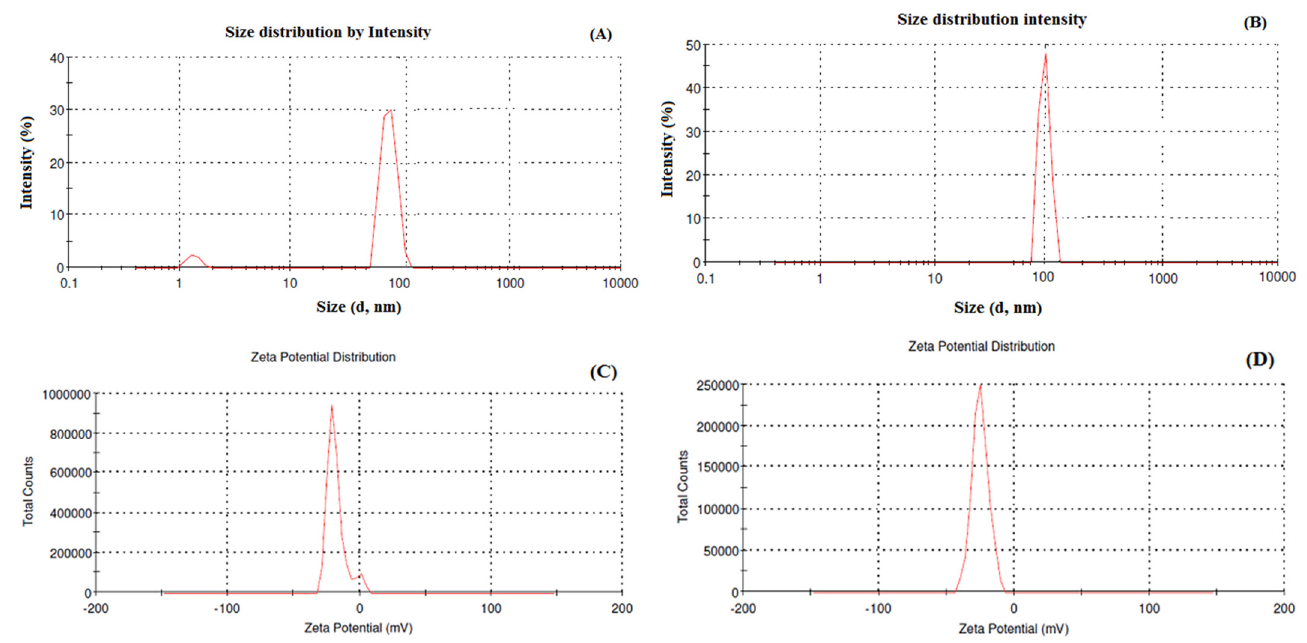
Figure 3. Particle size and size distribution analysis of Dox–Erlo NPs ( A ), particle size and size distribution analysis of Dox–Erlo-NP conjugates ( B ), zeta potential of Dox–Erlo NPs ( C ) and Dox–Erlo-NP conjugates ( D ). Table 5. The optimized composition using experimental design for the development of Dox–Erlo NPs with experimental and predicted responses.